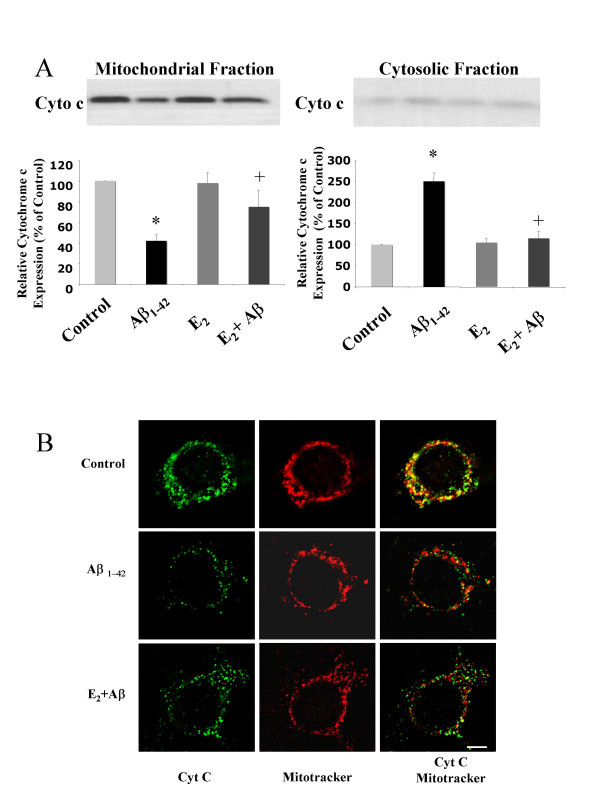
17β-estradiol prevents Amyloid beta1–42-induced cytochrome c release. Primary hippocampal neurons pretreated with E2 (10 ng/mL; 48 hr) or vehicle control were exposed to Aβ1–42 for 24 hr and assessed for cytochrome c expression by Western blot analysis and immunocytochemistry. A, Western blot analysis cytochrome c expression in cytosolic (right panel) and mitochondrial (left panel) fractions of treated neurons. B, Treated neurons were immunostained for cytochrome c expression (Green) and mitochondria were labeled with Mitotracker Red CMXRos (Red). Co-localization of cytochrome c with mitochondria is visible in the overlay image (yellow). Bar = 5 μm.